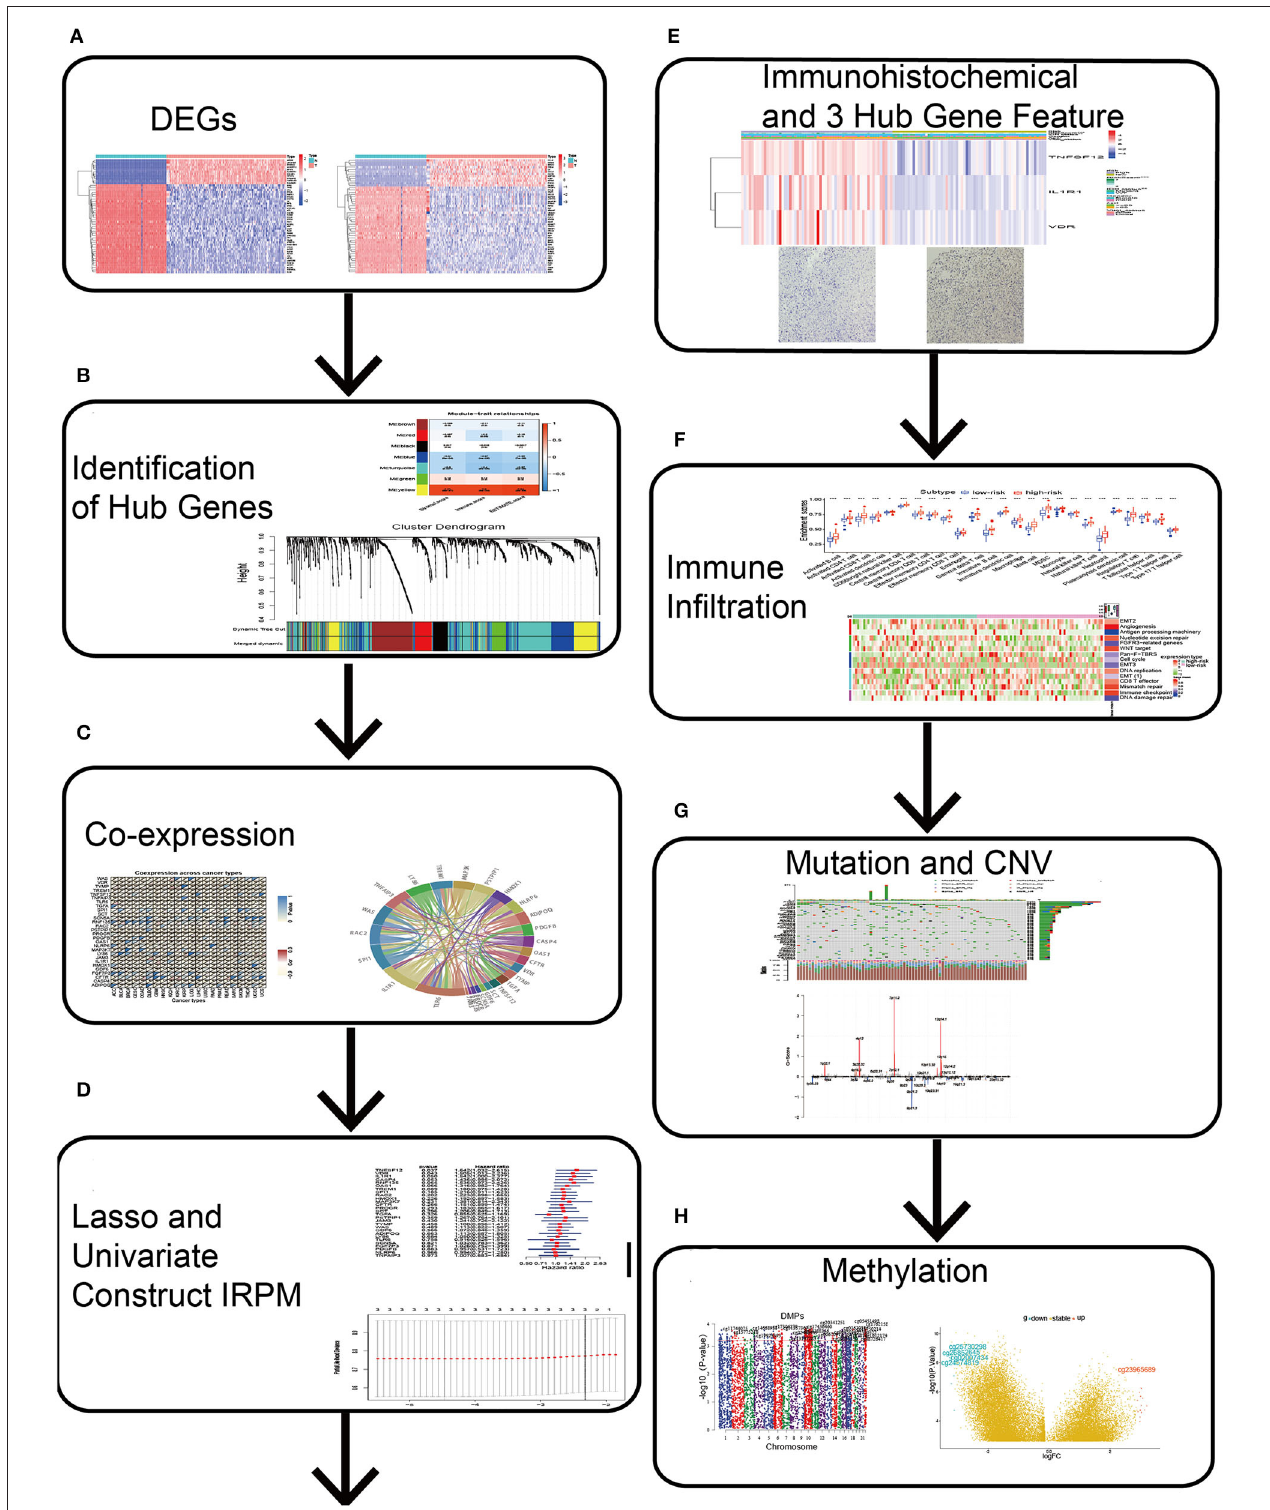
FIGURE 1 | Schematic diagram of this study. (A) Differential genes were obtained from GBM and normal brain tissue. (B) Hub genes were identified by Weighted Gene Co-Expression Network Analysis (WGCNA). (C) Clinicopathologic characteristics of 28 hub genes were analyzed. (D) Lasso and univariate regression were used to identify 3 key genes and the corresponding risk coefficients. (E) ICH and TIMER were used to analyse the clinicopathological characteristics of three key genes. (F) ssGSEA was used to analyse immune infiltration in both groups. (G) Maftools and Genomic Identification of Significant Targets in Cancer algorithm were used to analyse mutations and CNV in both groups. (H) ChAMP was used to analyse methylation in high and low-risk groups.